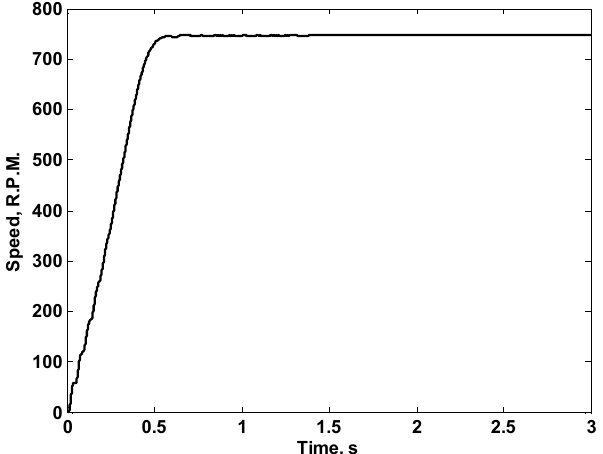
Figure 24. Motor Speed when Excited with 110 V, 25 Hz.